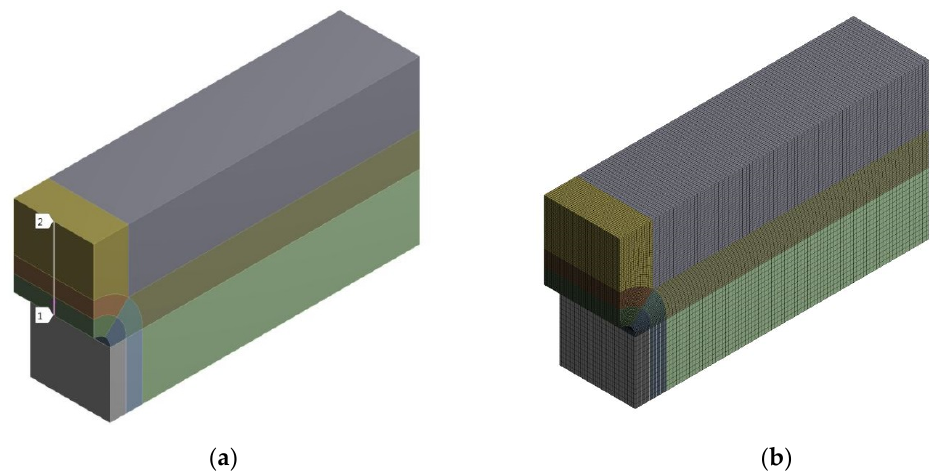
Figure 5. Geometry of the model used in finite element (FE) simulations, showing the middle line on the fracture section ( a ) and the generated mesh ( b ).